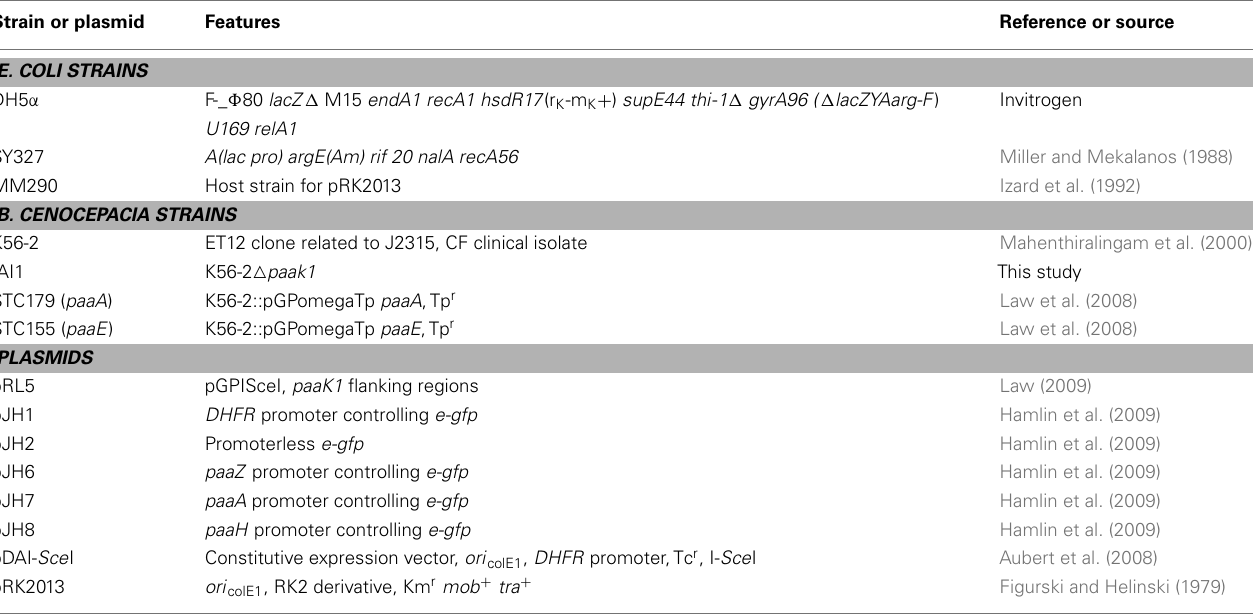
Table 1 | Bacterial strains and